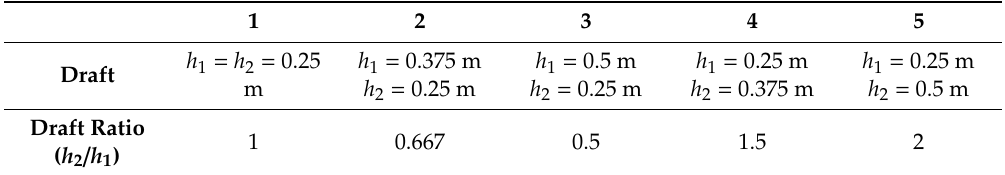
Table 1. Parameters for five different sets of simulations.